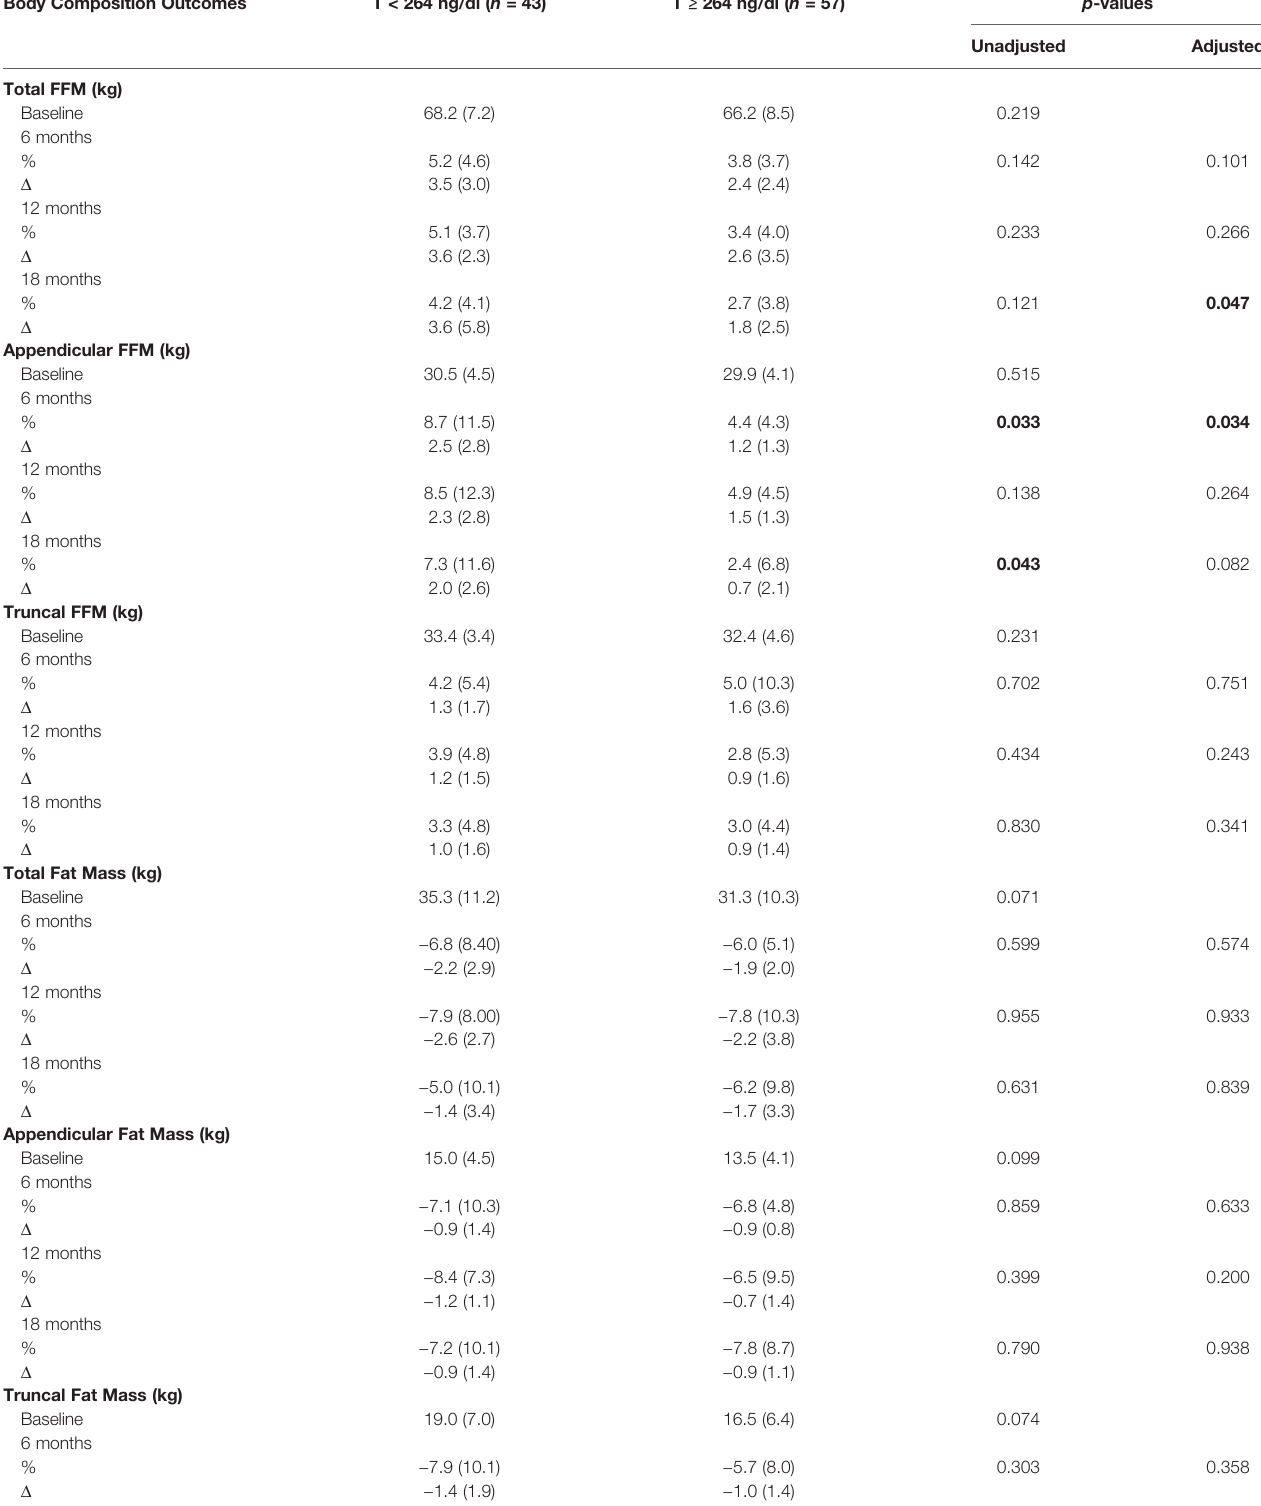
TABLE 2 | Changes in body composition with testosterone therapy from baseline to 18 months between the two groups. Body Composition